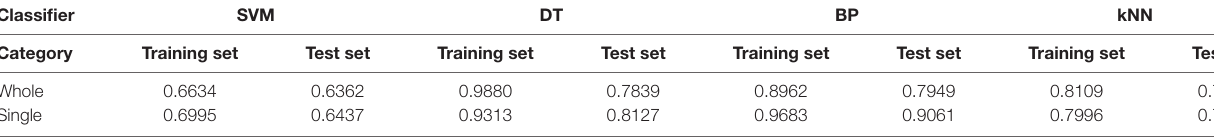
TABLE 2 | Classification effect on the baseline feature set.